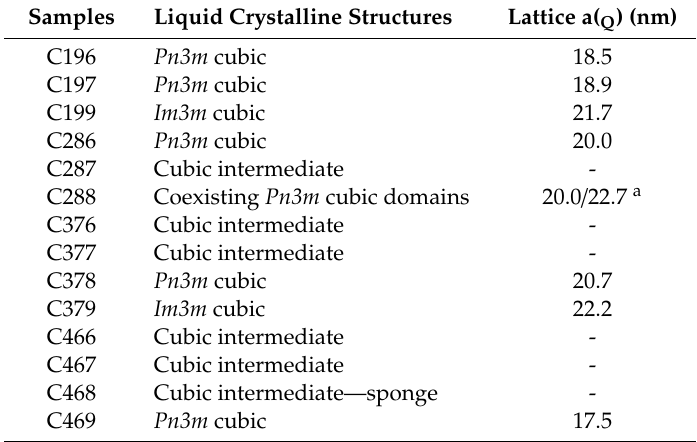
Table 1. Internal liquid crystalline structure types and lattice parameters of MO / TPEG 1000 / FO / CU / CAT self-assembled architectures determined from BioSAXS analysis of the data shown in Figure